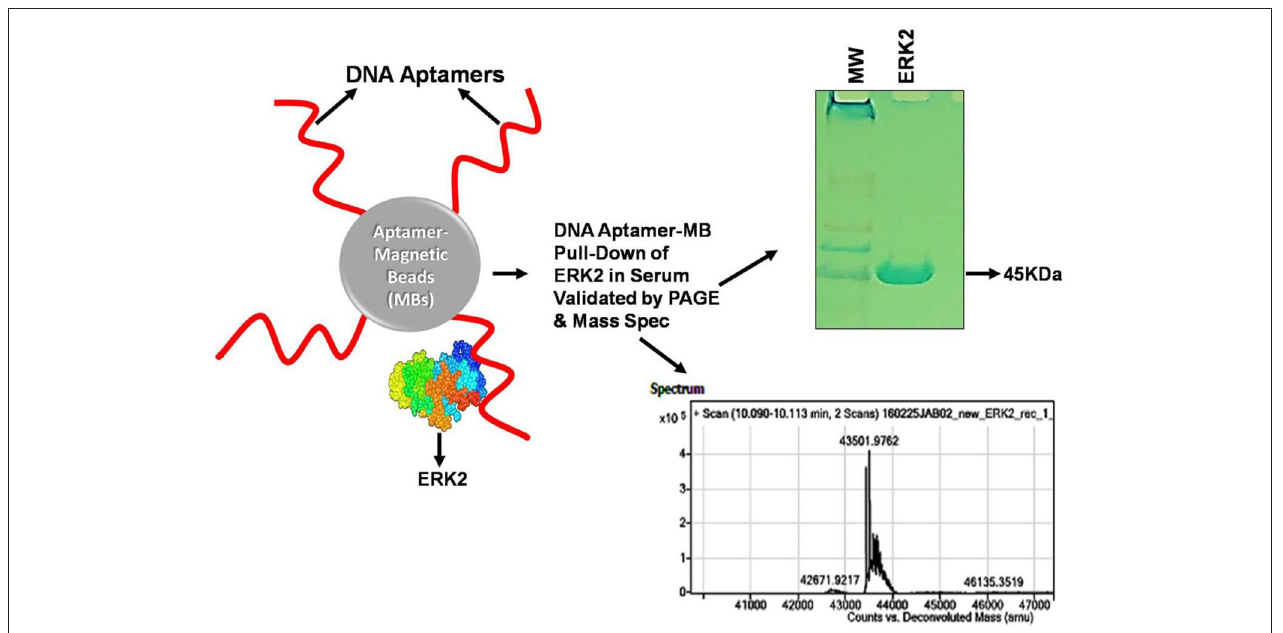
FIGURE 1 | Illustration of a cancer biomarker (ERK2) aptamer pull-down assay on aptamer-coated magnetic beads (MBs) performed in serum and analyzed by gel electrophoresis and mass spectrometry. The “clean” ∼ 43.5 kD ERK2 band shown in the gel and clear mass spectral signature virtually free of interfering signals from serum were likely due to original aptamer selection in diluted serum as well as the addition of 2mM EDTA to chelate free calcium ions, thereby enhancing aptamer specificity (Bruno, 2017b). Anti-ERK2 aptamers are shown as wavy red lines attached to MBs either covalently or via streptavidin-biotin linkages which then capture any free extant ERK2 or spiked recombinant ERK2 (rERK2) in serum samples. Following MB collection with a strong permanent magnet (pull-down), removal of serum, several buffer washes and elution of the ERK2 from the aptamer MBs in strong (0.1M) HCl, followed by removal of the aptamer-MBs and neutralization of ERK2 in the acid with 0.1M NaOH, the resultant eluate is electrophoresed in polyacrylamide and analyzed by mass spectrometry to validate its molecular weight (MW) and probable identity. A real experimental Coomassie Blue-stained 12% polyacrylamide gel and mass spectrum are shown from experimental pull-down assay runs.